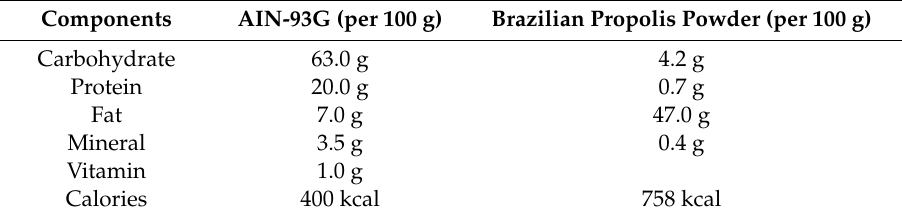
Table 1. Nutritional information of AIN-93G and Brazilian propolis powder of ethanol